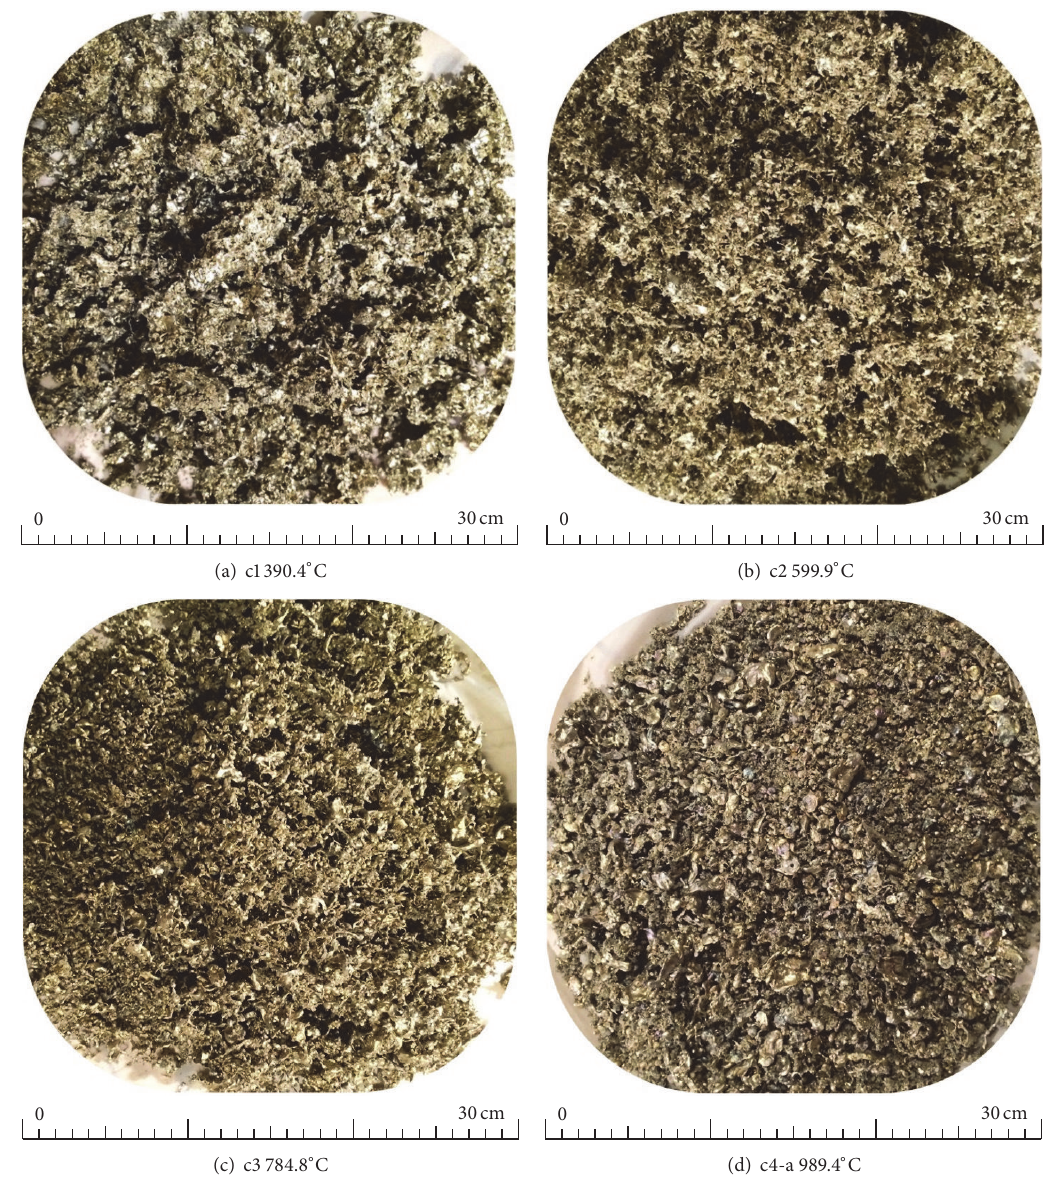
Figure 8: Debris collected after